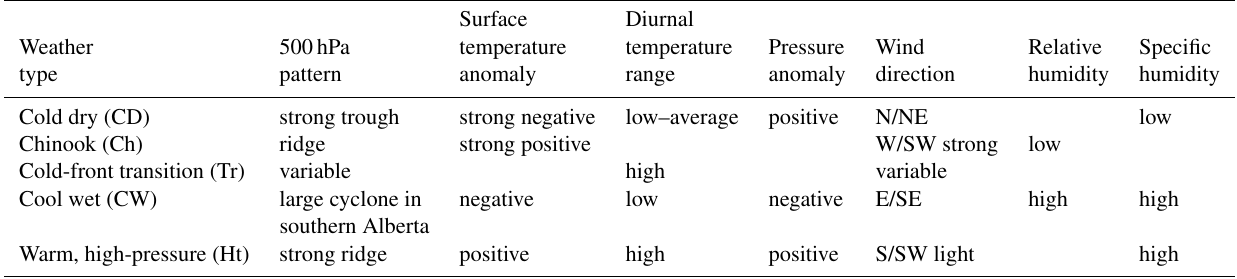
Table 4. Selected qualitative surface meteorological characteristics associated with different weather types in southern Alberta. Surface Diurnal Weather 500hPa temperature temperature Pressure Wind Relative Specific type pattern anomaly range anomaly direction humidity humidity Cold dry (CD) strong trough strong negative low–average positive N/NE low Chinook (Ch) ridge strong positive W/SW strong low Cold-front transition (Tr) variable high variable Cool wet (CW) large cyclone in negative low negative E/SE high high southern Alberta Warm, high-pressure (Ht) strong ridge positive high positive S/SW light